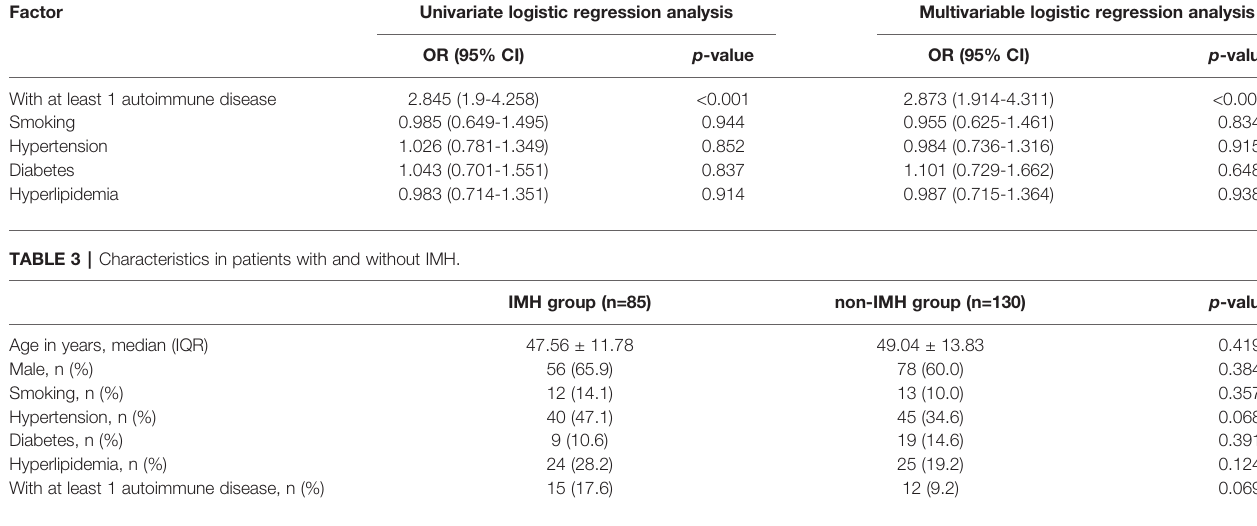
TABLE 2 | Conditional multivariable logistic regression analysis showed having an autoimmune disease was associated with increased odds of SCCAD. Factor Univariate logistic regression analysis